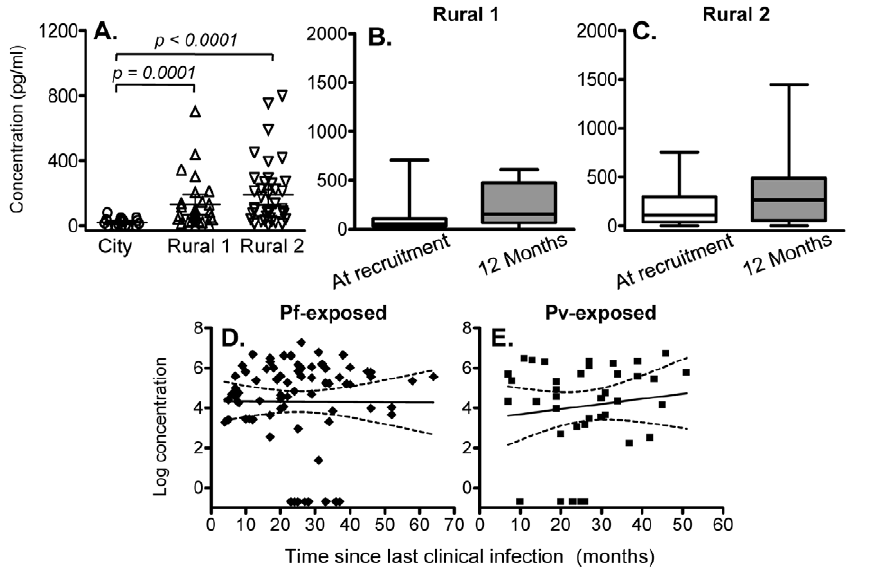
Figure 3. IL-10 concentrations in 6 day cell culture supernatants. (A) Concentration (mean 6 95% CI) of IL-10 in 6 day, PfSE-stimulated culture supernatants at recruitment. IL-10 concentrations in 6 day, PfSE-stimulated culture supernatants at recruitment and 12 months later in Rural 1 (B) and Rural 2 (C) subjects. [Horizontal line = median; box =25 th and 75 th percentiles; whiskers = minimum and maximum values]. Paired t -tests were used to analyse differences between the two time points. Best-fit regression analysis of the 6 day IL-10 response to PfSE over time in P. falciparum -exposed (D) and P. vivax -exposed (E) subjects. Solid lines represent best fit regression lines estimating the rates of decline of the 6 day cytokine responses over time and dashed lines represent the 95%